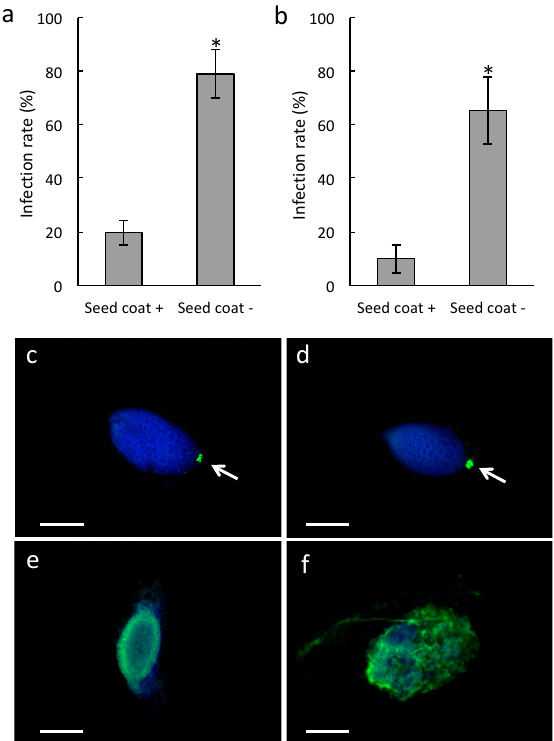
Figure 4 . Bletilla striata seeds inoculated with pathogenic fungi. B. striata seeds were inoculated with Rhizoctonia Solani ( a , c , e ) or Fusarium oxysporum ( b , d , f ). ( a , b ) Infection rate of B. striata seeds. Gray bars indicate the infection rate defined as hyphal proliferation at three weeks after sowing (see also Figure S3). Seed coat +, intact seeds; Seed coat − , seed coat-stripped seeds. Error bars represent standard errors of the means of four independent experiments. The asterisk shows significant difference between the treatments as determined by the Student’s t -test at p < 0.01. ( c – f ) Colonization of B. striata seeds by R. solani or F. oxysporum . The images show three-week-old protocorms that were stained with calcofluor white (blue) and WGA-Alexa fluor-488 (green) to visualize the plant cell and fungal structures, respectively. ( c , d ) Intact seeds; ( e , f ) seed coat-stripped seeds. Arrows indicate the suspensor end. Scale bars, 200 µm.